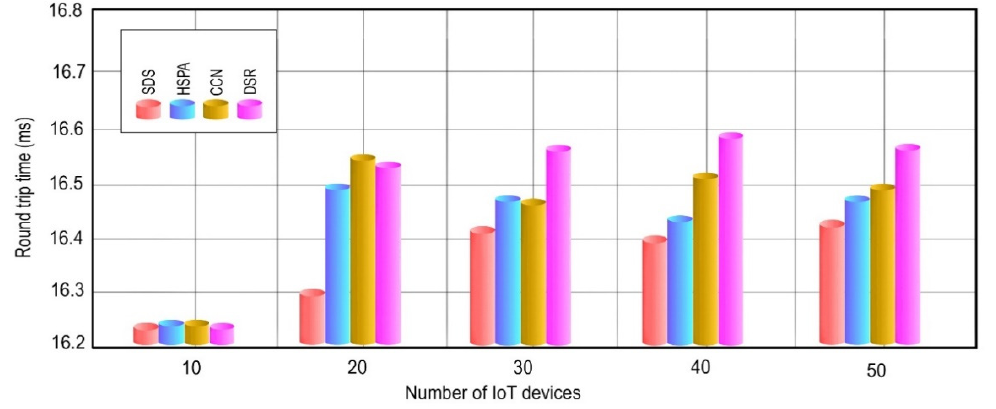
Figure 4. Round trip time computation.